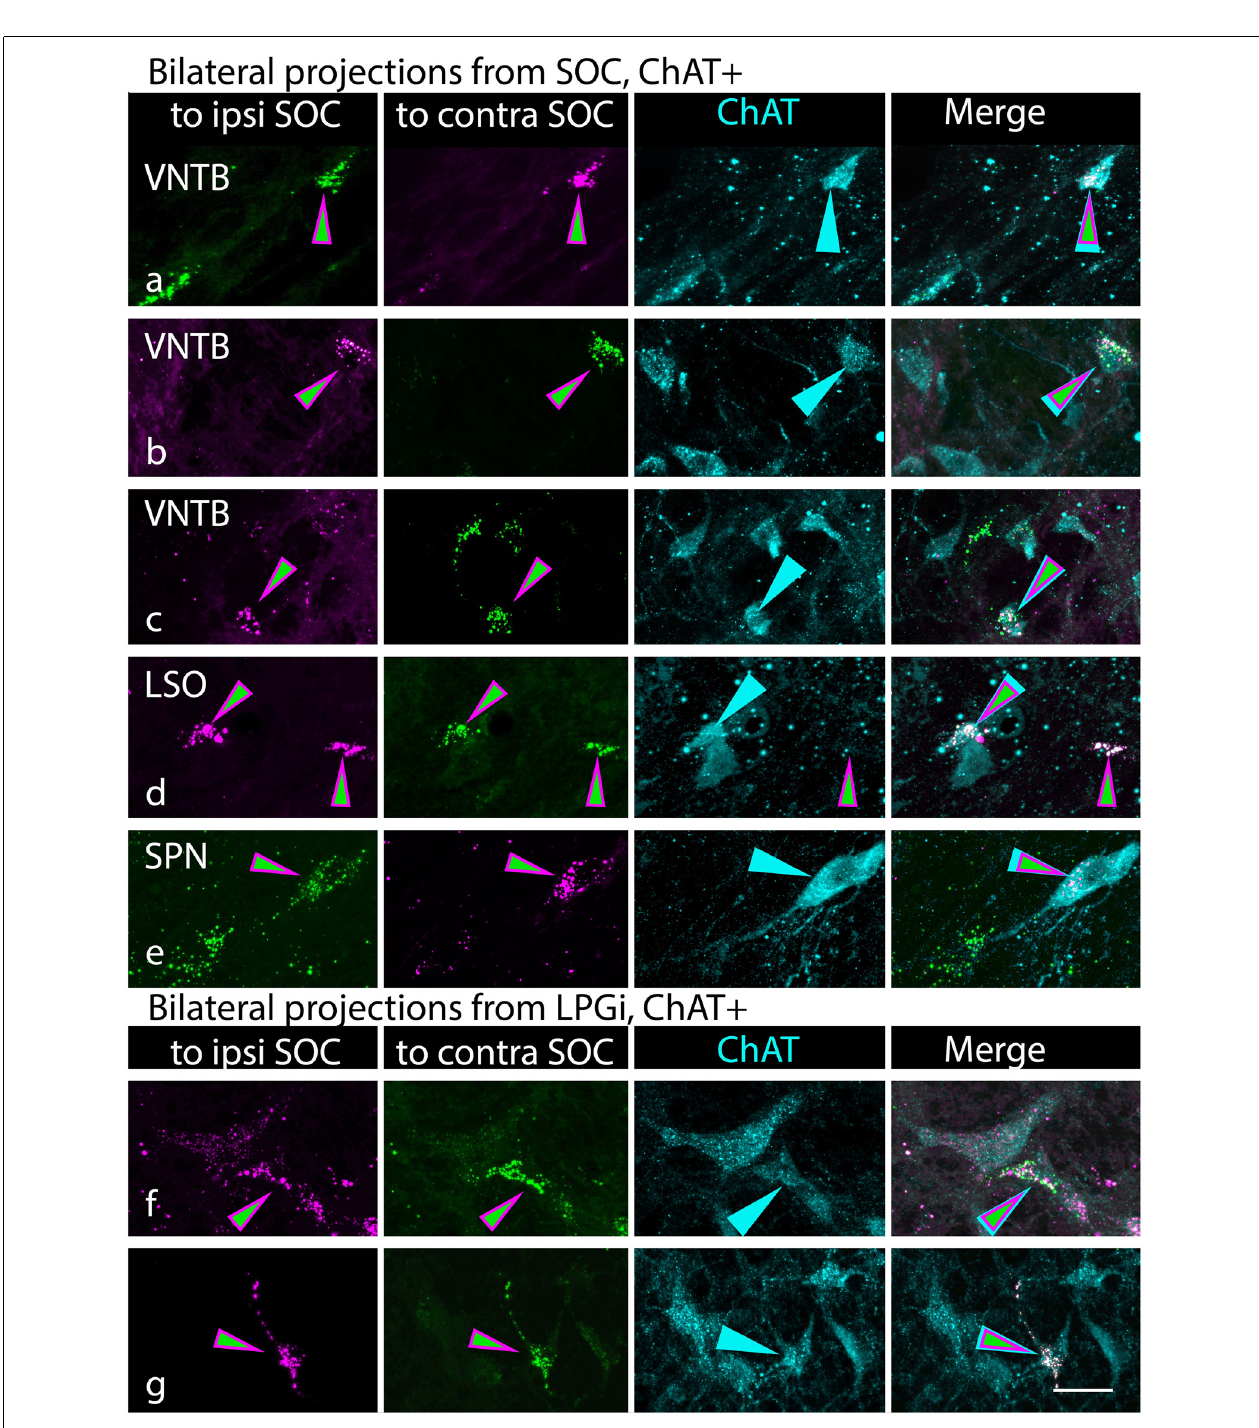
FIGURE 8 | Cholinergic cells in the superior olivary complex (SOC) and lateral paragigantocellular nucleus (LPGi) send branching axonal projections to innervate the SOC bilaterally. Each row of photographs shows a single field of view. The first two columns show the tracer label (RB in magenta; GB in green), with the first column showing the tracer injected into the ipsilateral SOC and the second column showing the tracer injected into the contralateral SOC (relative to the labeled cells). Magenta/green arrows identify cells that contain both retrograde tracers. Column 3 shows the ChAT staining, with cyan arrows pointing to the same cells as in the first two columns. Column 4 shows the merged image, highlighting the triple-labeled cells. (A–E) Triple-labeled cells were found in numerous SOC nuclei, indicated by the labels in column 1. VNTB, ventral nucleus of the trapezoid body; LSO, lateral superior olivary nucleus, SPN, superior paraolivary nucleus. ChAT-negative cells could also be labeled with both retrograde tracers (panel D , cell on the right). (F,G) Triple-labeled cells in the LPGi. Panels (A,B, and F) are from G18-2012 (medial SOC deposits); panels (C,D, and E) are from G18-3033 (lateral SOC deposits); panel (G) is from case G18-3030 (medial SOC deposits). Scale bar = 20 µ m.